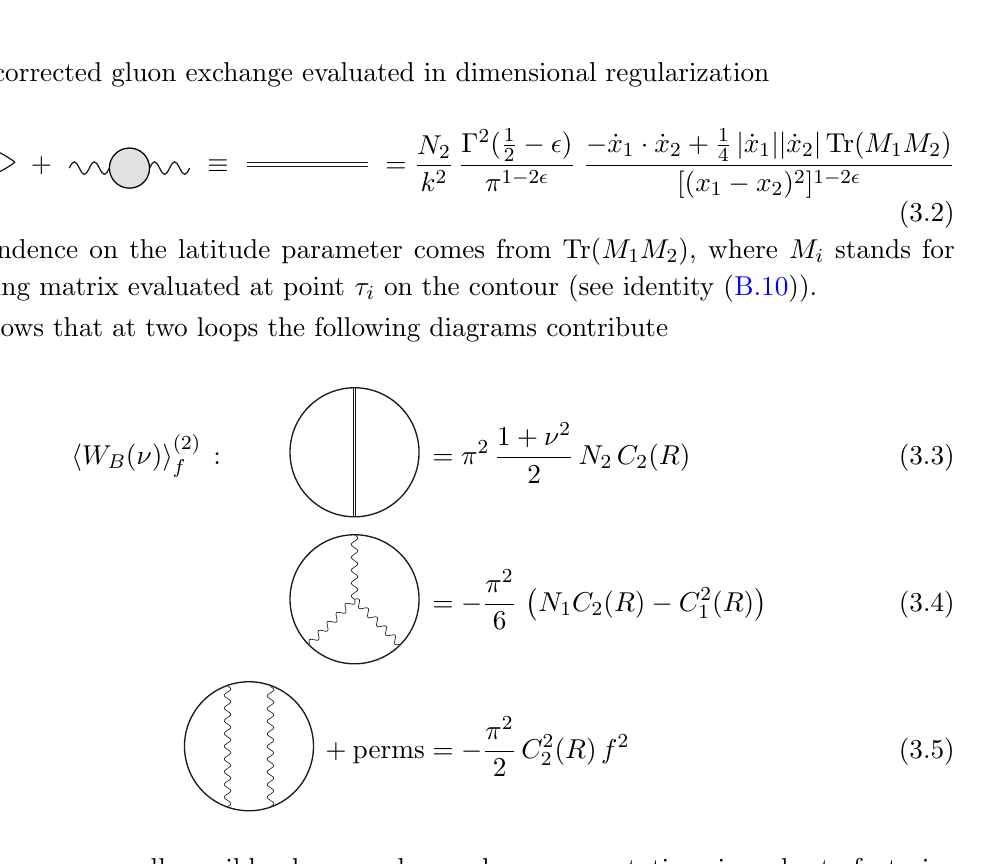
Figure 1. Diagrams contributing to the bosonic latitude three-loop expectation value. Wavy and solid lines stand for gluons and scalars,